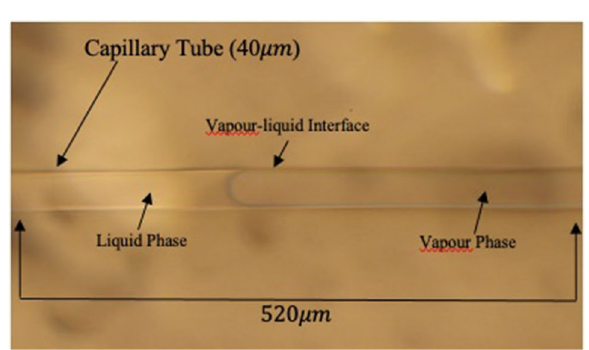
Figure 4. Propane vaporization in the 40 μm capillary